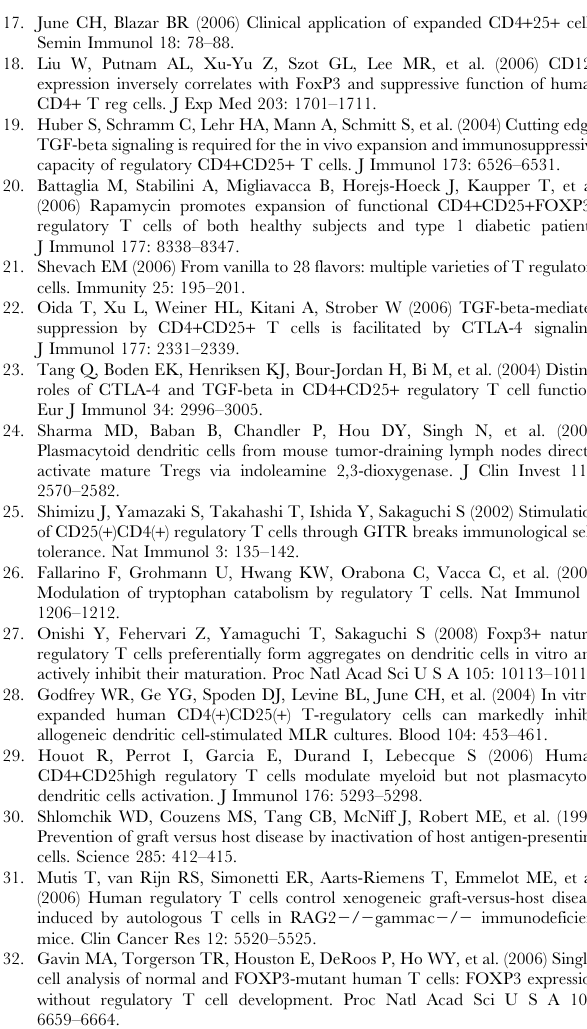
dose of effector T cells and APC populations were 1 6 10 7 and transplant, the number of human CD4 + and CD8 + T cells in